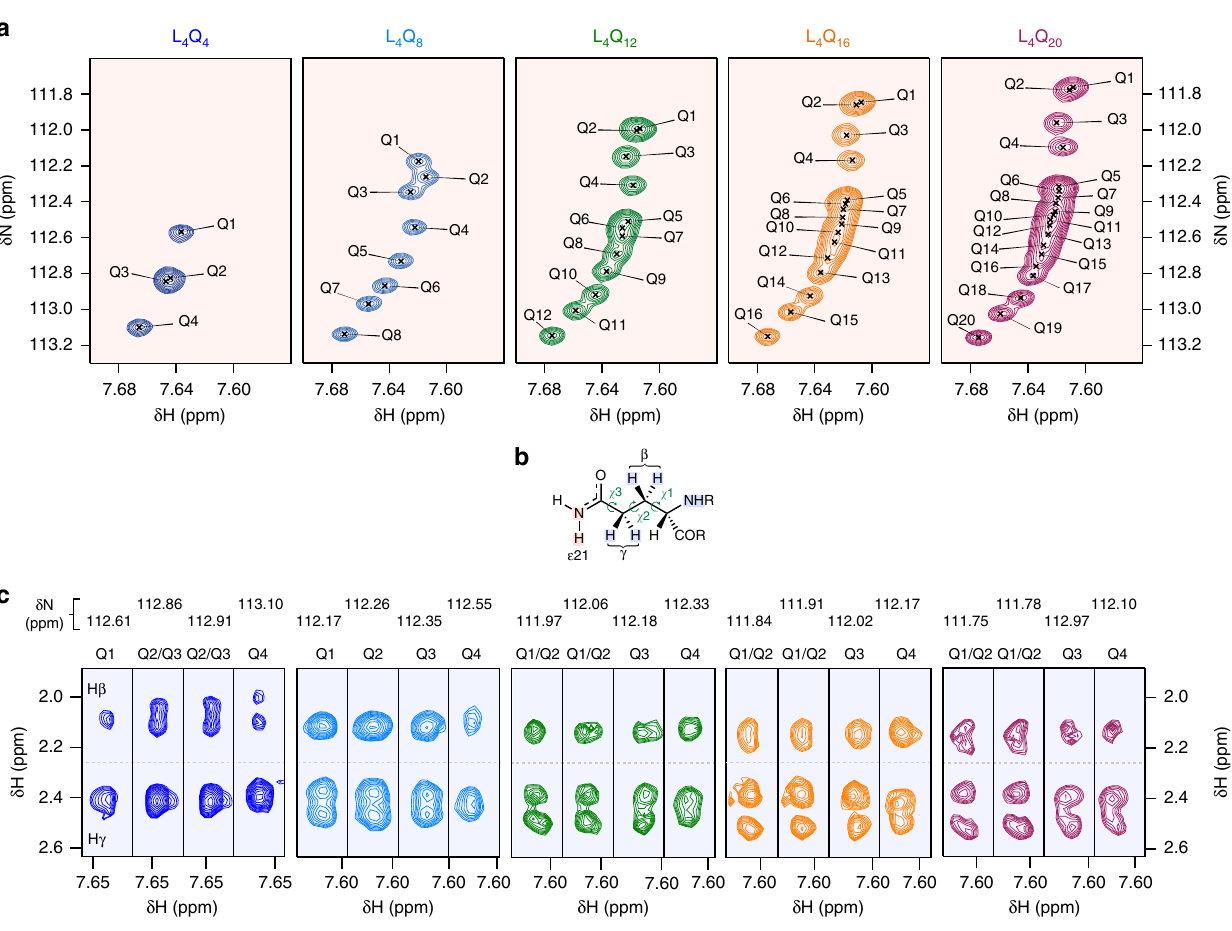
Fig. 2 The conformations of the Gln side chains are well de fi ned. a Expanded regions of the 1 H, 15 N heteronuclear single quantum correlation (HSQC) spectra of peptides L 4 Q 4 to L 4 Q 20 showing the H ε 21 side chain resonances. b Structure of the Gln side chain with an indication of the nuclei whose resonances are shown in a (red shade) and in c (blue shade). c Regions of the 15 N planes of the H(CC)(CO)NH spectra of peptides L 4 Q 4 to L 4 Q 20 measured at pH 7.4 and 278 K containing the side chain aliphatic 1 H resonances of the fi rst four residues (Q1 – Q4) of the polyQ tract. All nuclear magnetic resonance (NMR) spectra were measured at pH 7.4 and 278